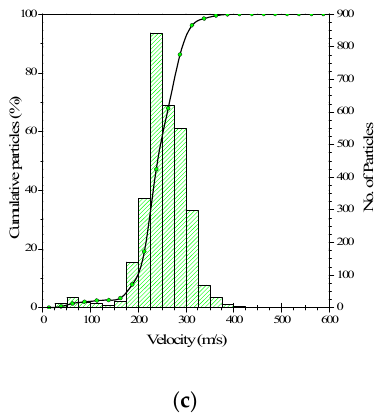
Figure 1. Experimental results of ( a ) size distribution measured by light scattering of raw material and in-flight particles and their corresponding ( b ) temperature and ( c ) velocities recorded with the DPV-Evolution at a stand-off distance (SOD) = 90 mm.